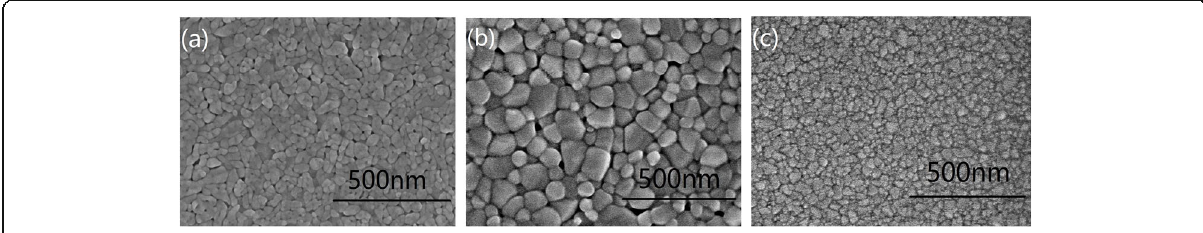
Fig. 5 SEM images of the surface morphologies for a VO, b VTO, and c VTRO-3